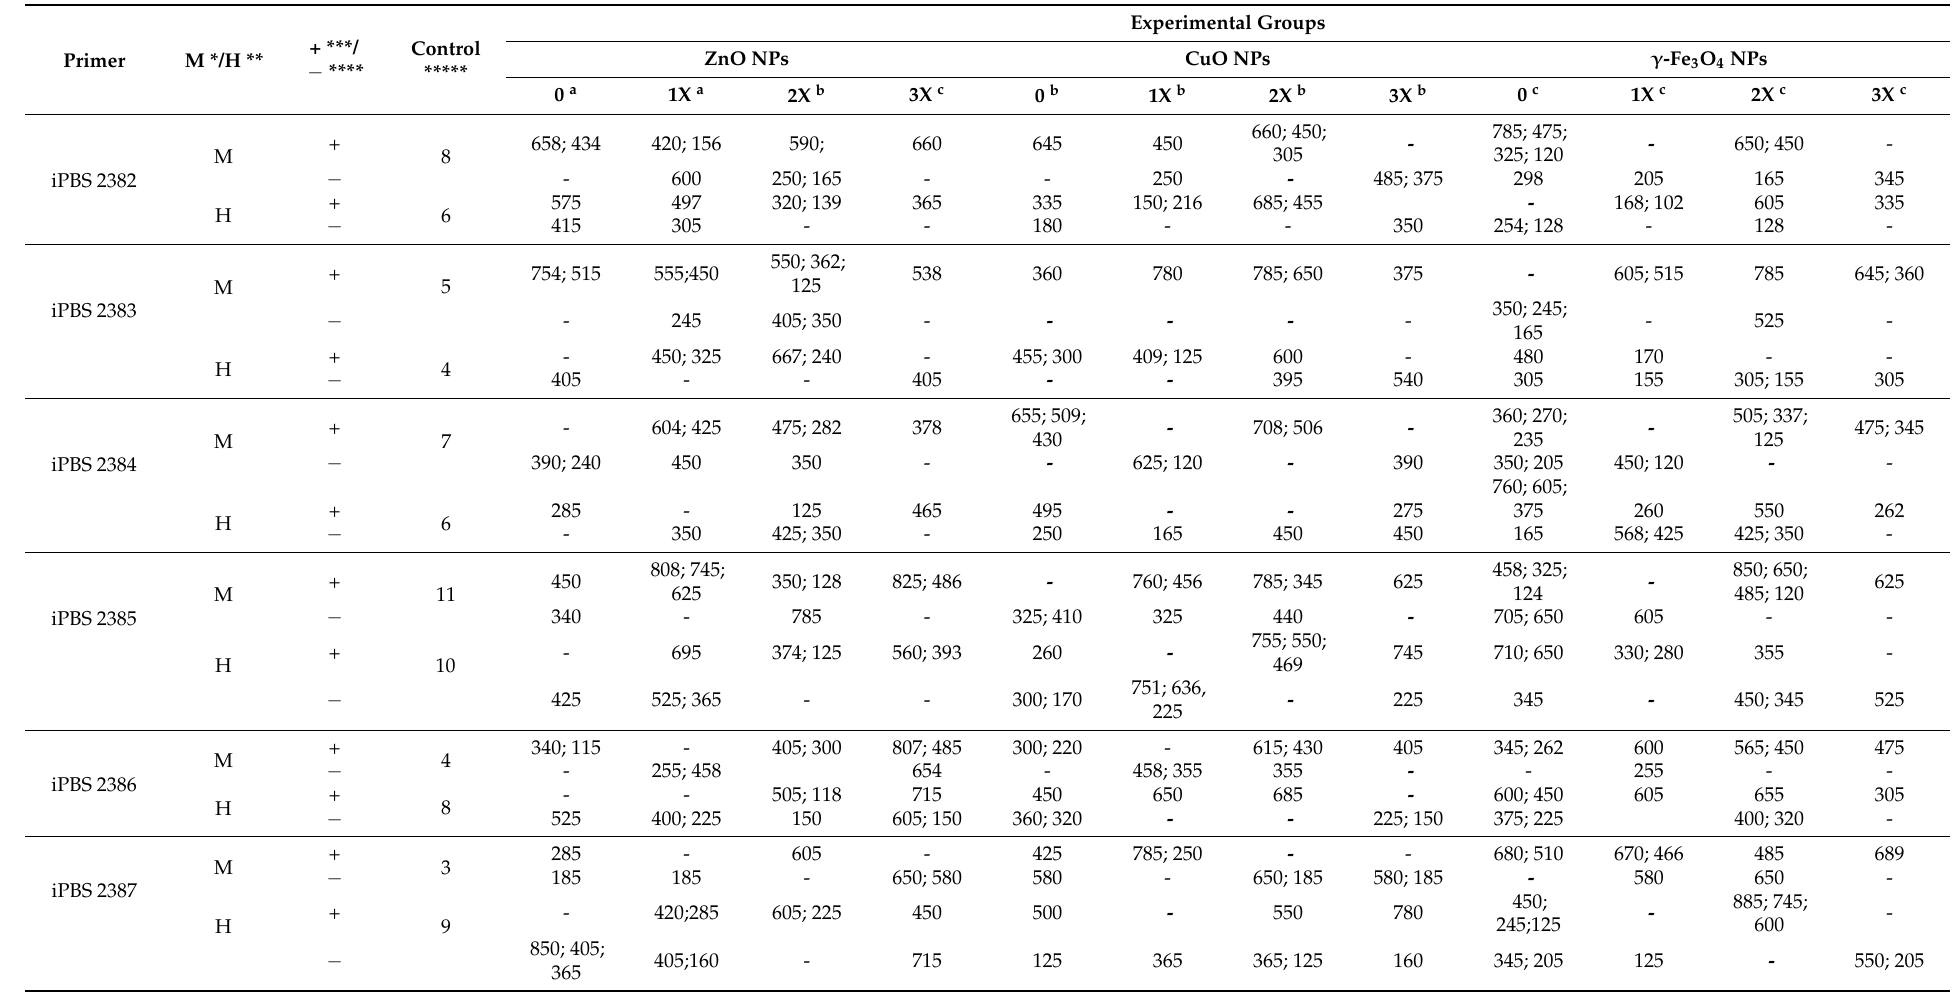
Table 2. Results of CRED-iPBS analysis; the molecular size of bands and polymorphism